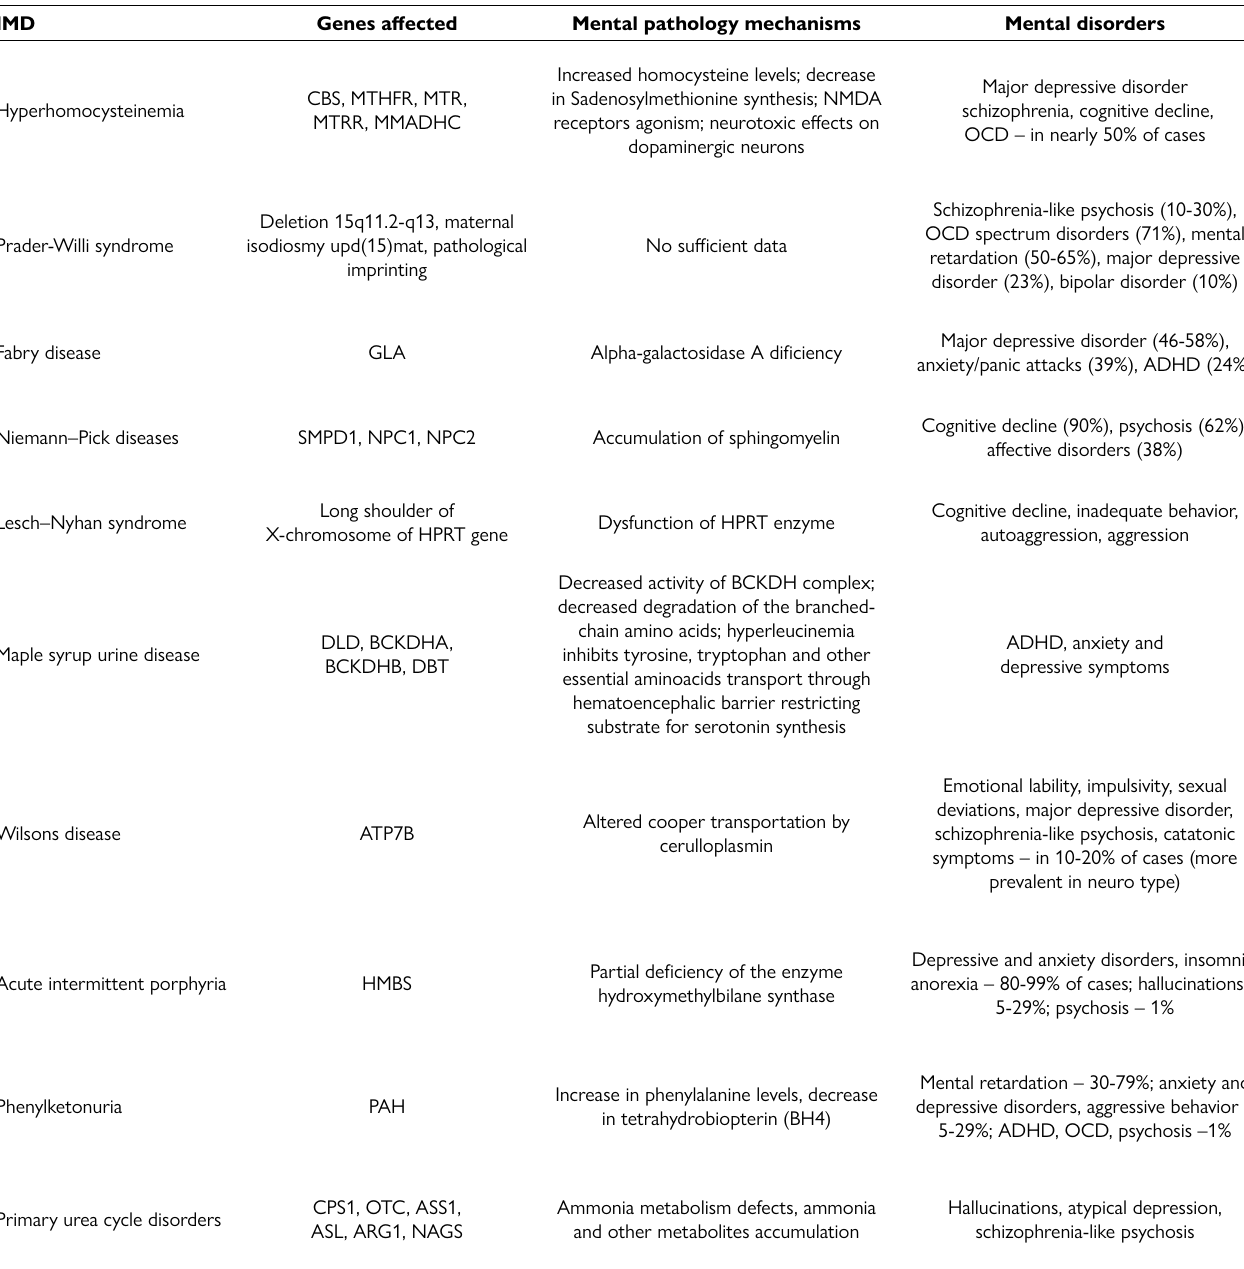
Table 1. Mental disorders in different types of